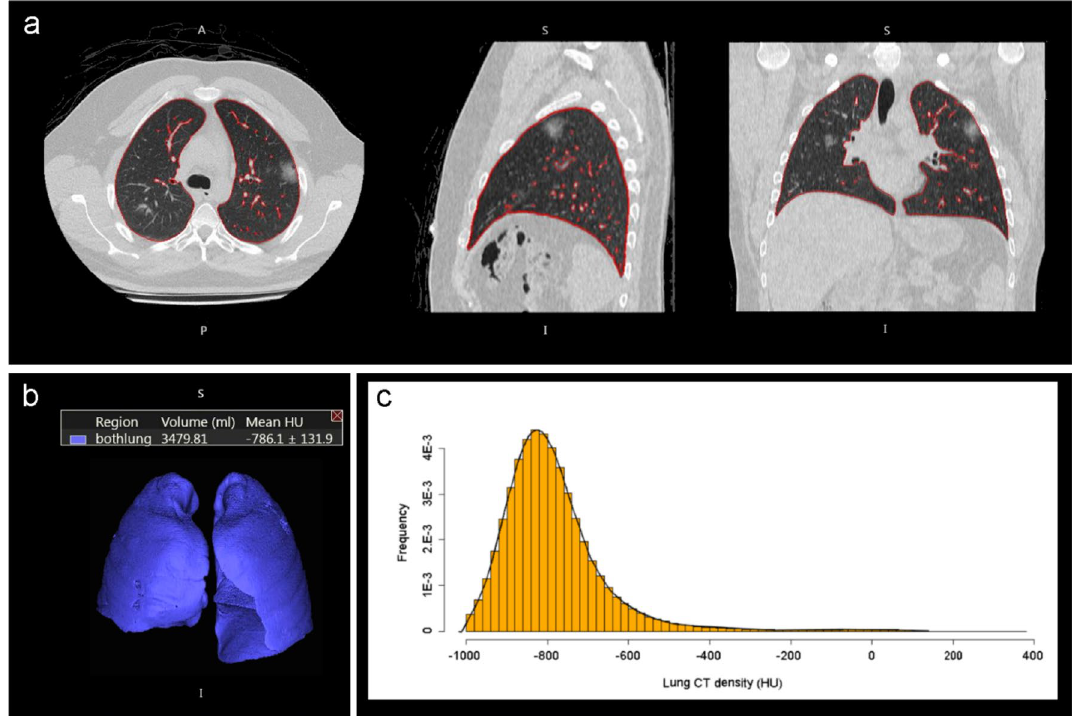
Figure 4. Non-contrast chest CT images in a 28-year-old man with mild COVID-19 pneumonia. The patient was discharged 3 days later without ventilation or ICU admission. ( a ) CT images show small, rounded ground- glass opacities in the upper lobes. ( b ) 3D view with volume. ( c ) Histogram of CT density values for both lungs shows most lung voxels in a normal lung density distribution and peak at about − 800 HU. (perc. = percentile). Mean lung CT density: − 786.1HU (21st perc.), SD-CT: 131.9HU (29th perc.), Skewness: 2.58 (97th perc.), Kurtosis: 13.40 (92nd perc.), Q875: − 664HU (19th perc.), F1: − 0.43 (19th perc.), F2: -0.05 (39th (ROC) area under the curve (AUC) metric for continuous predictors and odds ratio (OR) for binary predictors. First quartile to third quartile differences were used for defining OR in non-categorical variables. Optimal cutoff points on ROC curves were determined using the Youden index method. In the multivariate analysis, predictive accuracy (AUC) of the final logistic regression models were corrected for overfitting using a Bootstrap cross-validation method. Backward variable selection was performed separately for models with qualitative assessment variables (subjective reader scores) and those with quantitative CT Imag- ing feature combined with 1 clinical biomarker for critically ill outcome. Highly correlated CT density predictors SD-CT, Q875 and F1 were tested in separate models. See Table 2. Final model selection was based on Bootstrap overfitting corrected AUC. The length-of-stay estimate for Covid patients have recently been addressed with numerous methods 34 . In